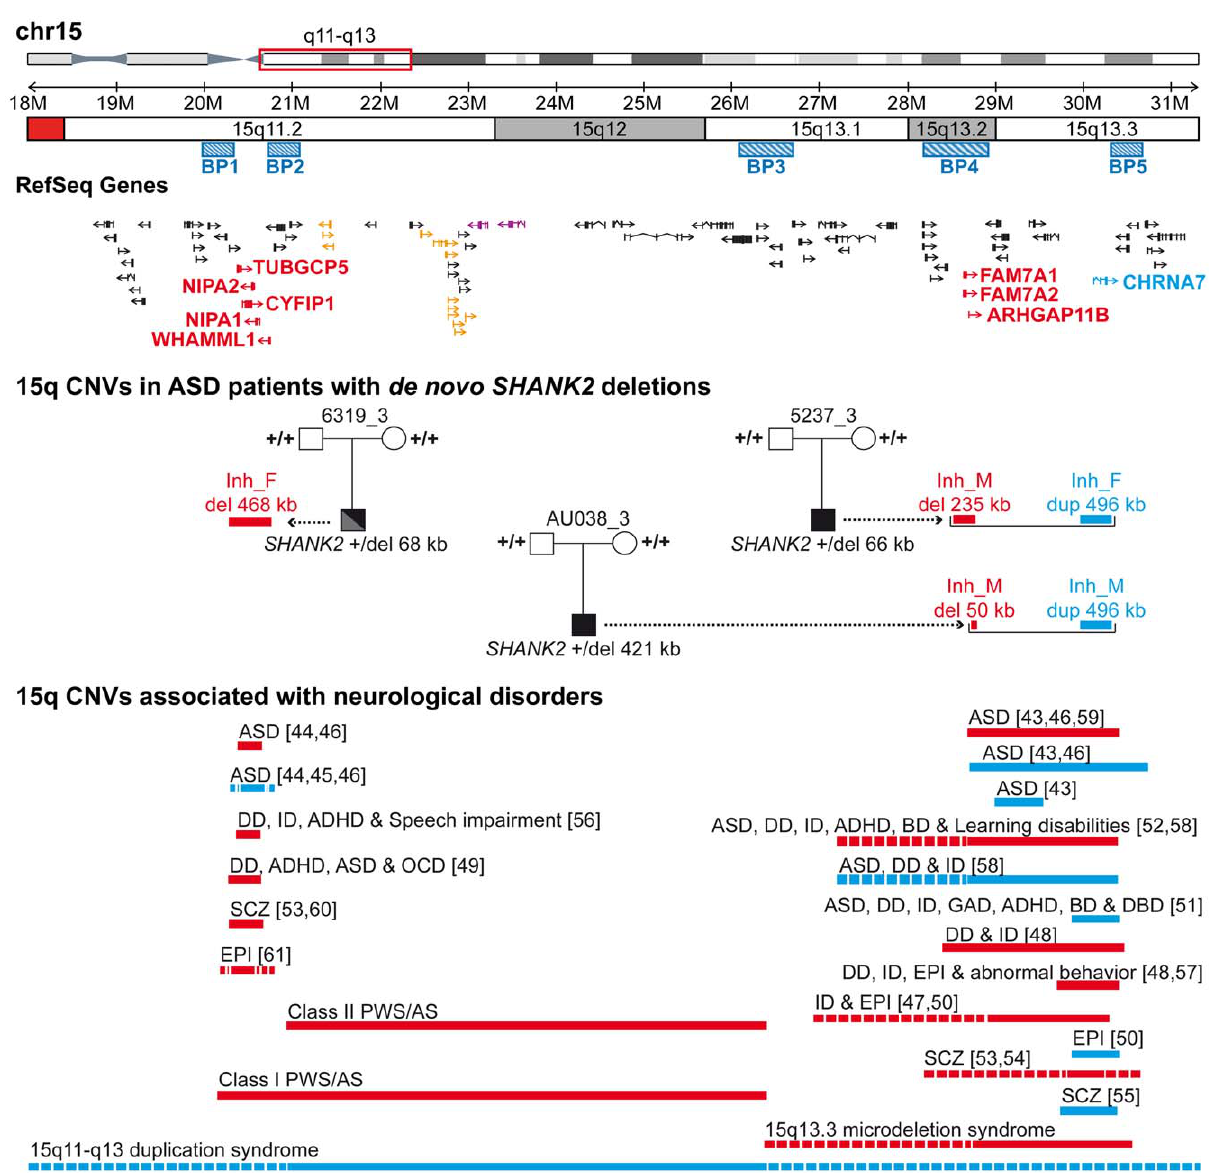
Figure 6. Inherited 15q11–q13 CNVs identified in three ASD patients carrier of a denovo SHANK2 deletion. Deletions (del) and duplications (dup) are indicated in red and blue, respectively. Paternally and maternally imprinted genes are indicated in yellow and pink, respectively. Genes altered by the CNVs are indicated in blue or red. The bottom part of the figure indicates the location of the deletions/duplications previously associated with neuropsychiatric disorders [43–61]. BP, breakpoint; Inh_M, inherited by mother; Inh_F, inherited by father; AS, Angelman syndrome; ASD, Autism spectrum disorders; ADHD, attention deficit-hyperactivity disorder; BP, bipolar disorder; DD: developmental delay; DBD, disruptive behavior disorder; EPI, epilepsy; GAD, generalized anxiety disorder; OCD, obsessive-compulsive disorder; ID, intellectual disability; PWS, Prader-Willi syndrome; SCZ, schizophrenia.